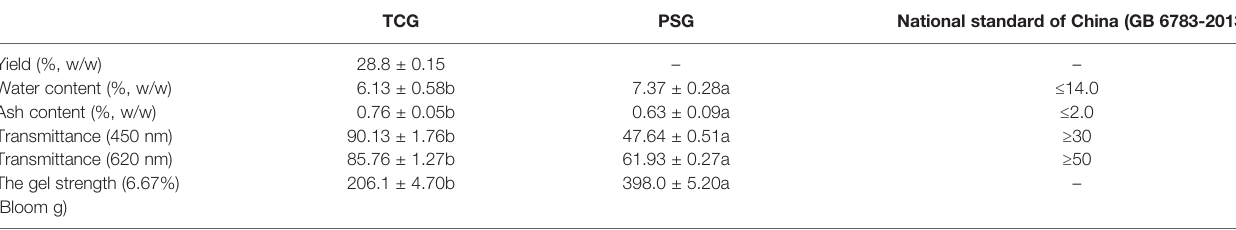
TABLE 2 | Basic properties of cartilage gelatin (TCG) from Siberian sturgeon (TCG).